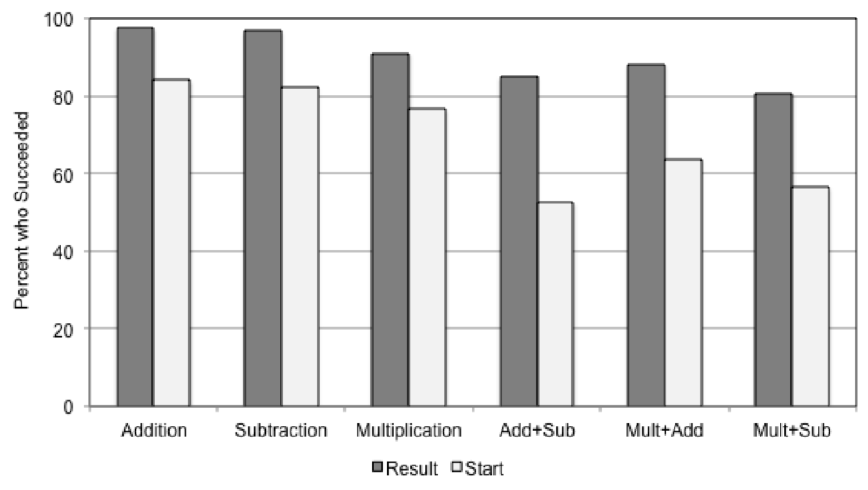
Figure 1 . Percent of participants who succeeded on the equation-solving task for each operation or operation combination and each position of the